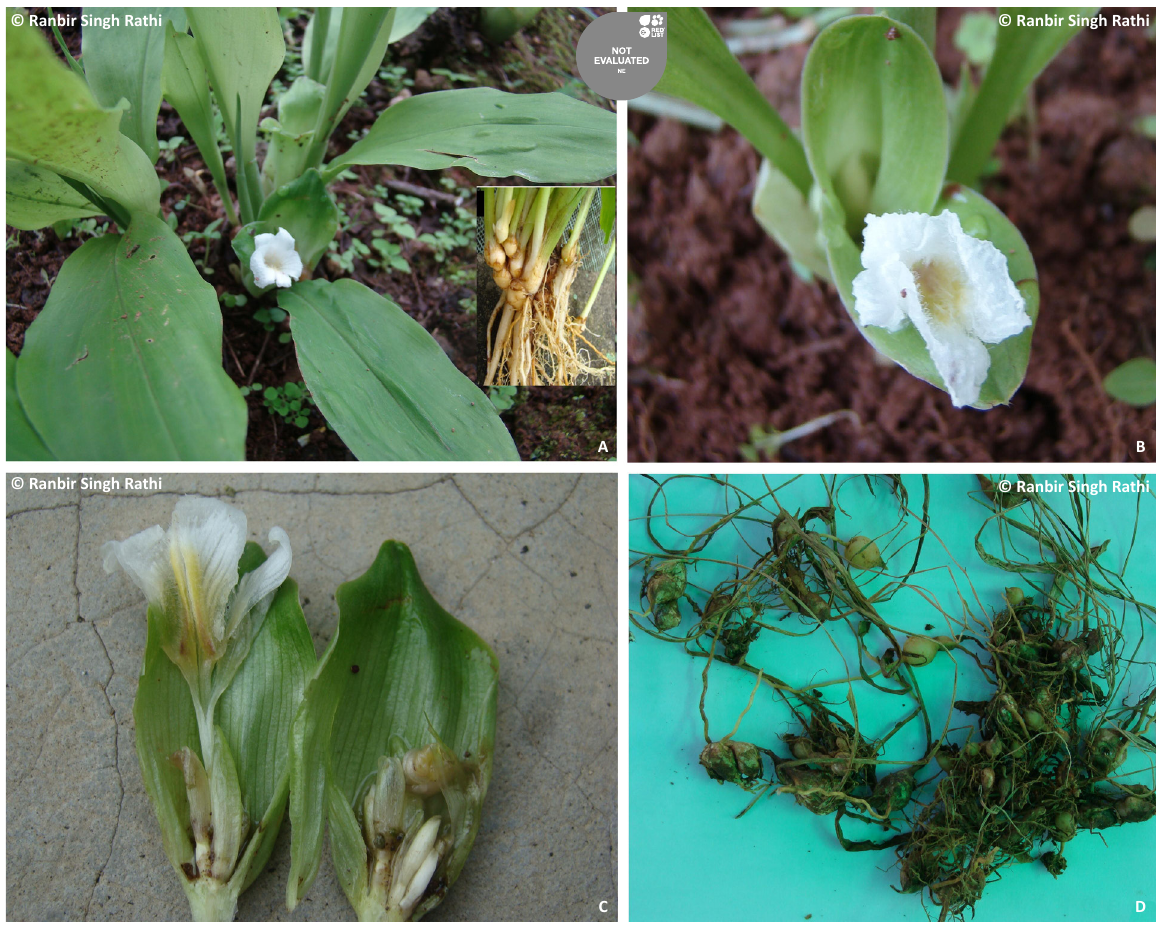
Image 1. Stahlianthus involucratus A - Habit - flowering plant (inset: rhizome with roots at early stage); B - Inflorescence showing flower; C - Exposed inflorescence showing translucent bracteoles, corolla tube and labellum; D - Rhizomes, tubers and roots at